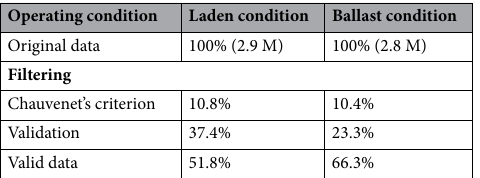
Table 5. Percentage of valid operational data after filtering and